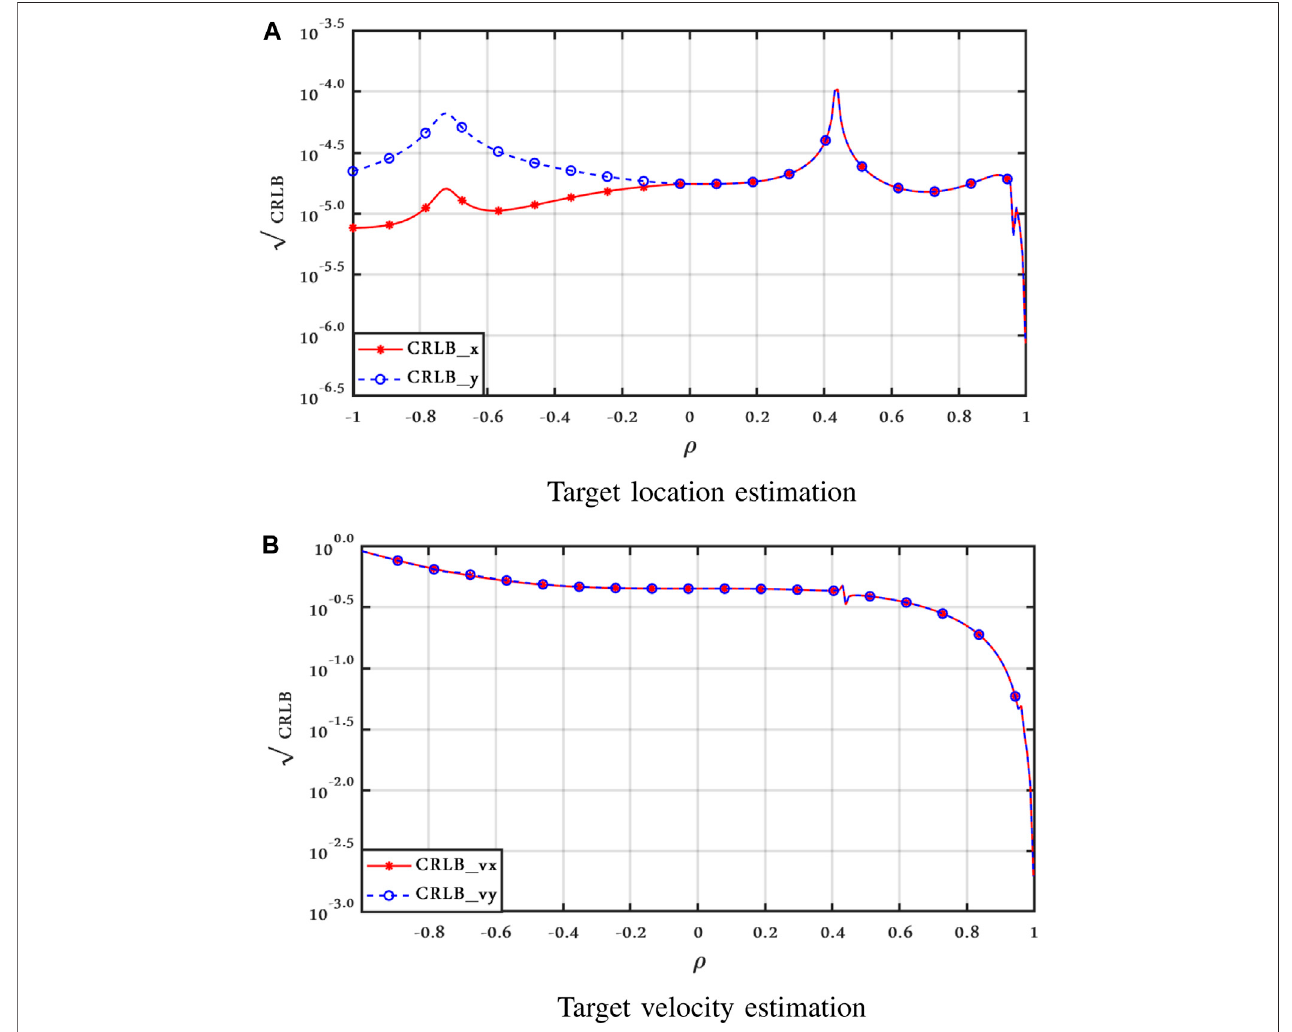
FIGURE 9 | CRLBs vs. ρ f, Clutter Model II with ] = 2.1, SCR = 0 dB , and v x = v y = 50 m/s.